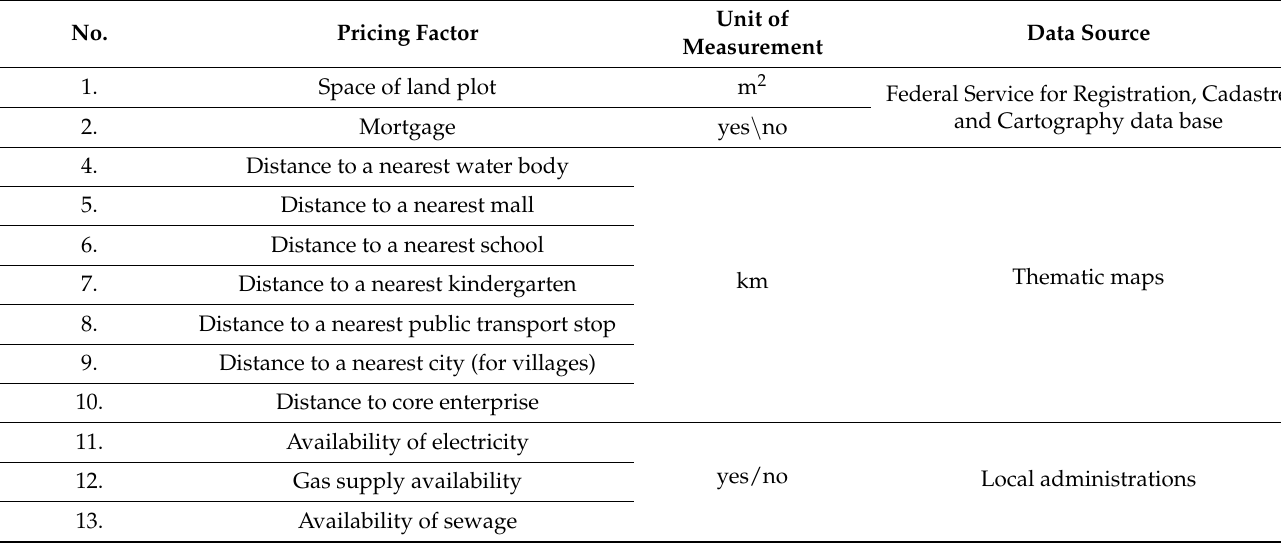
Table 4. List of pricing factors.